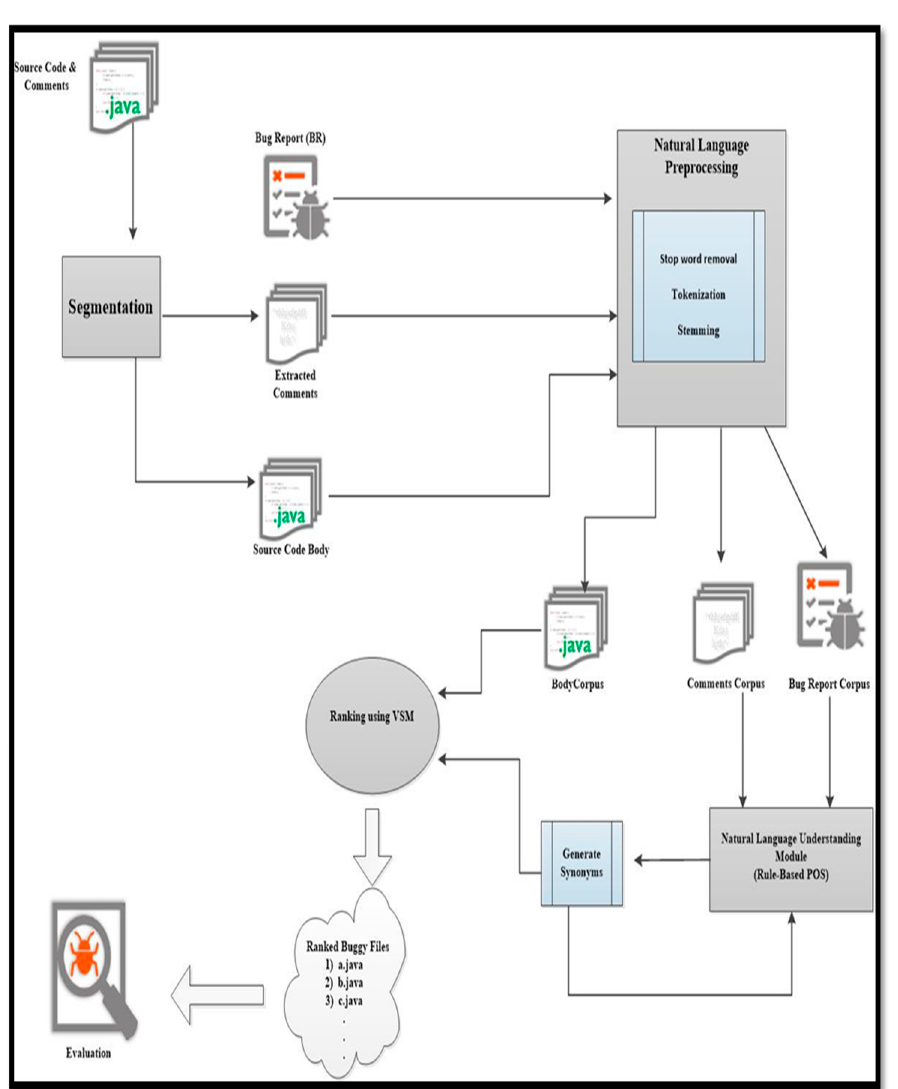
Figure 2. The study methodology.